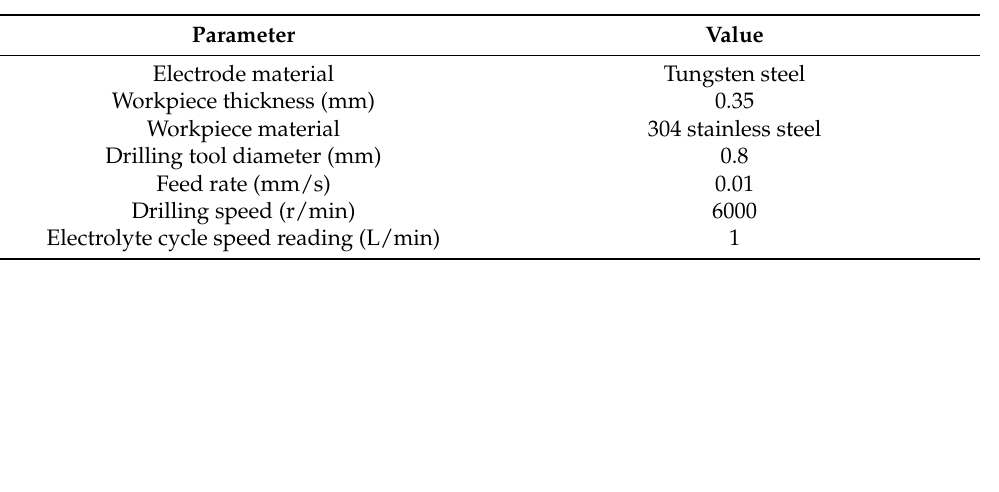
Figure 14. Test platform : ( a ) Schematic diagram; ( b ) Physical photos.